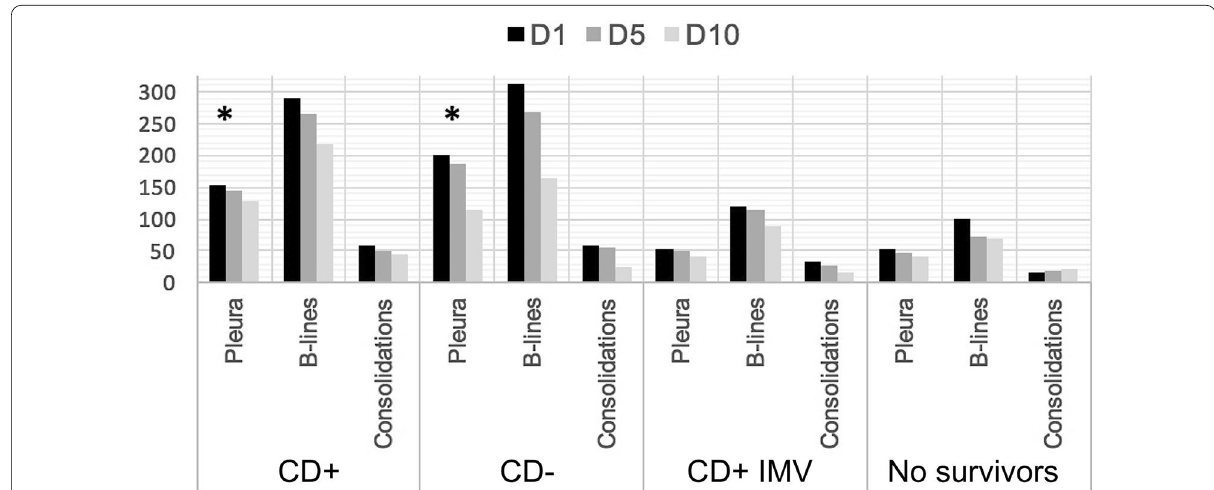
Fig. 2 Number of abnormal LUS findings during hospital stay evaluation time points D1–D10 in all groups of patients: CD of cardiac dysfunction; CD : patients with no signs of cardiac dysfunction; CD − who died during their stay. All types of B-lines evaluated were grouped. The number of patients included is different for each time point (Table 2). *Statistical difference between groups ( p <